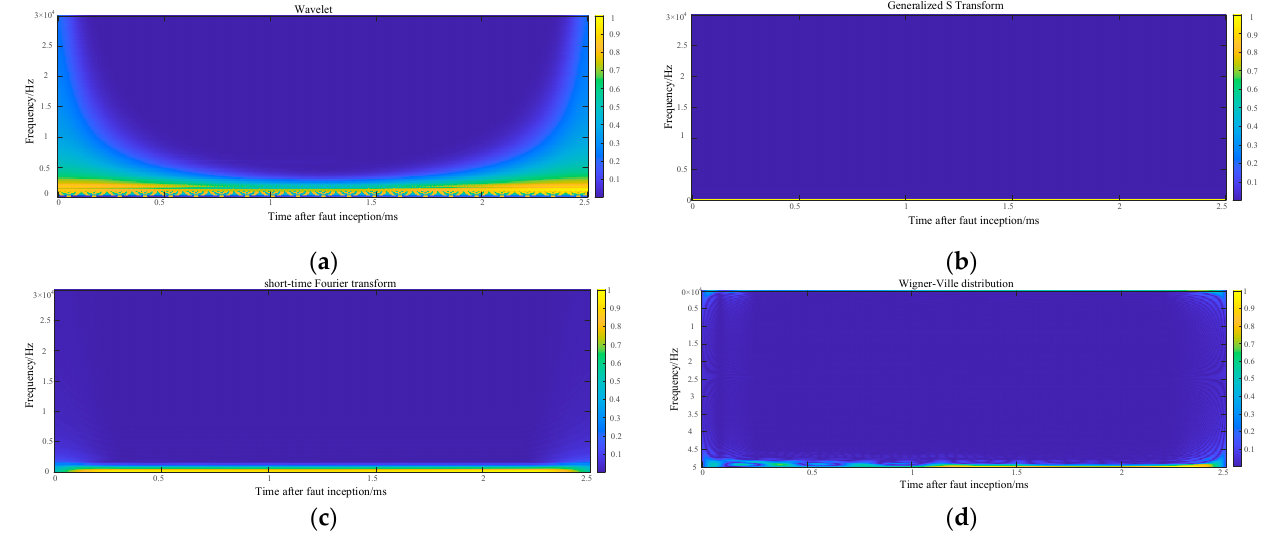
Figure 11. Simulation results comparison: ( a ) Wavelet based method ( b ) S-transform based method ( c ) Short Time Fourier transform based method ( d ) Wigner-Ville distribution-based method.